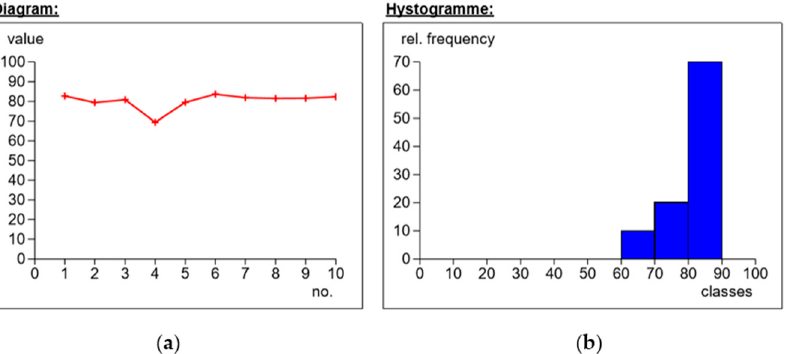
Figure 8. Application of Dialead K63712, weave 0/+90 ◦ , MGS L285/H285 warp: ( a ) dependence of hardness on the number of measurements; ( b ) percentages of hardness.